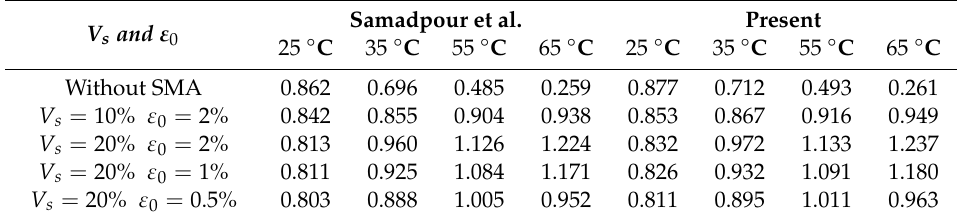
Table 2. Comparison of non-dimensional natural frequencies for sandwich composite plate embedded SMA with Samadpour et al.